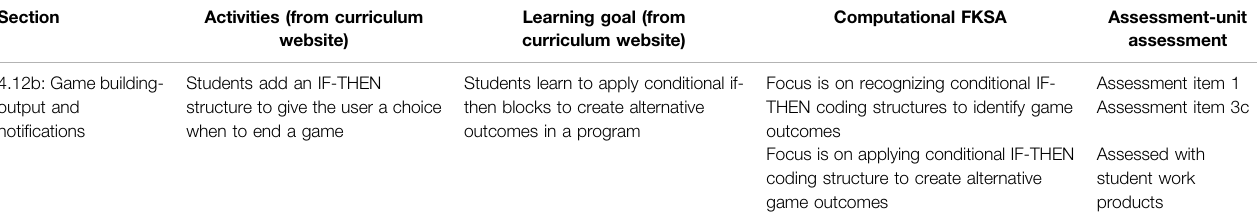
TABLE 1 | Sample section of unit 4 partial design